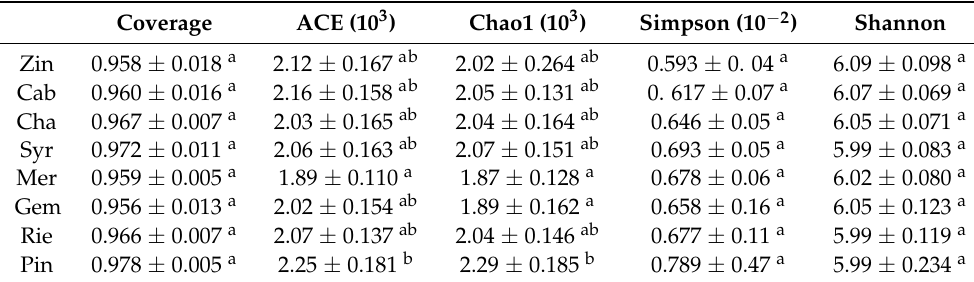
Superscript different letters indicate a significant difference between different grape varieties. Table 2. The alpha-diversity of fungal communities.